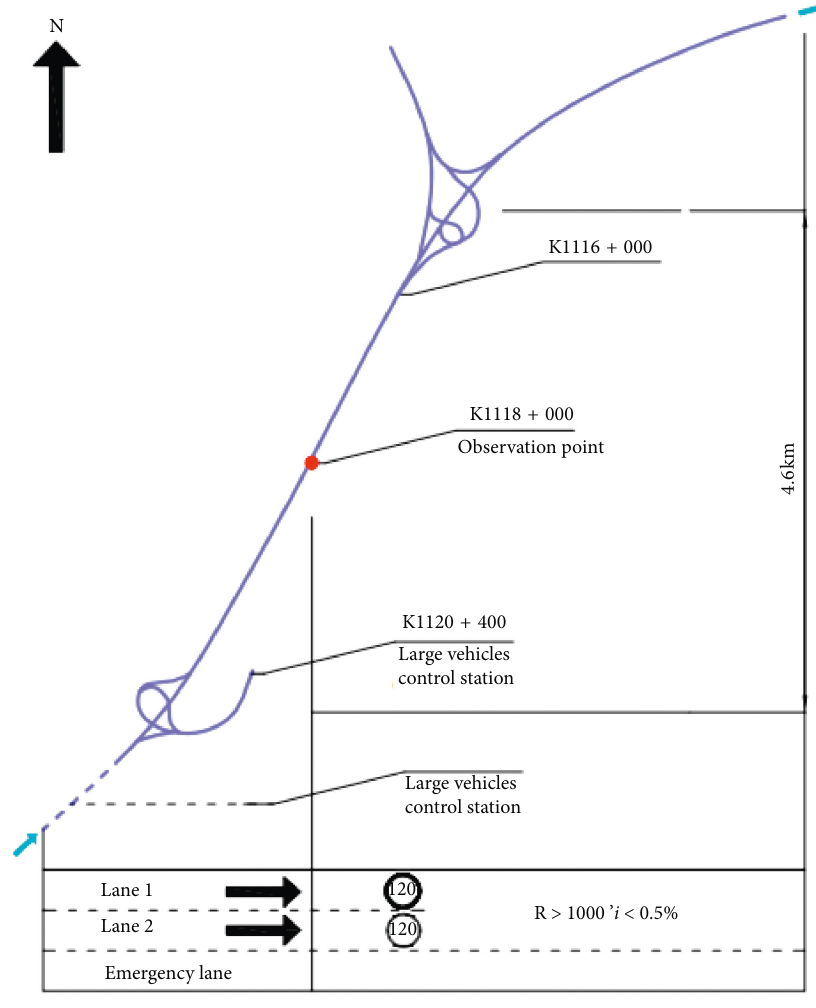
Figure 2: Layout of observation points.